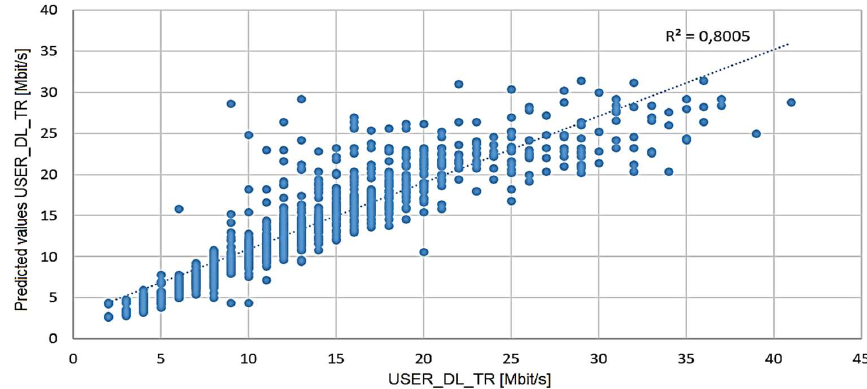
Figure 7. Scatter plot of the prediction results for the M17 J-D